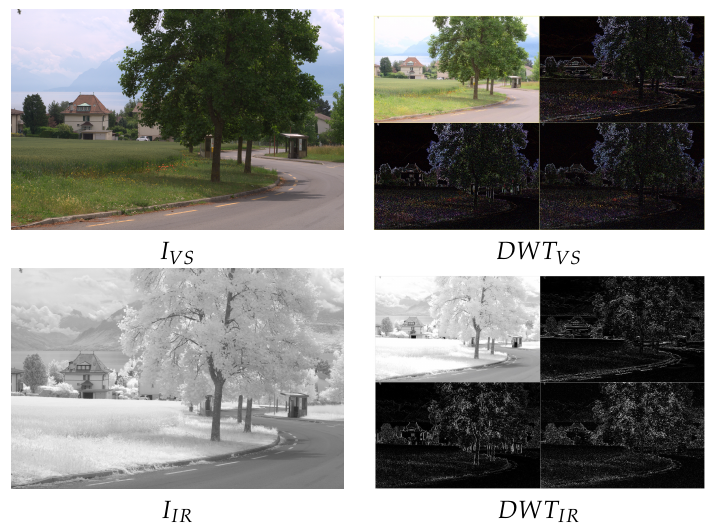
Figure 1. ( Left ) Pair of images (VS-IR) to be fused; ( Right ) DWT decompositions (one level) of the input